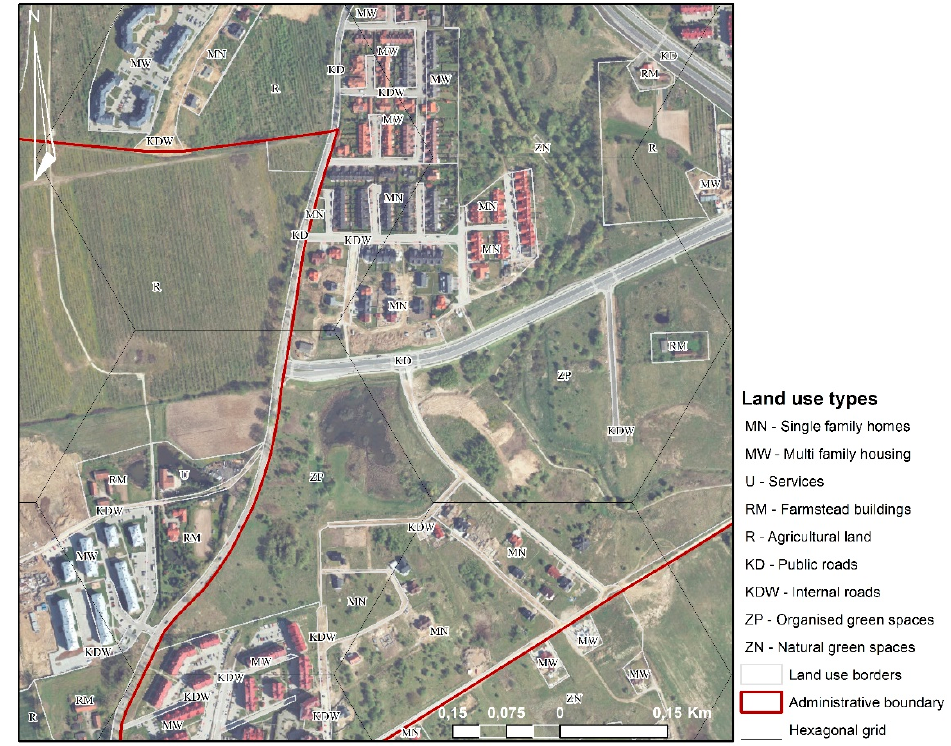
Figure 4. Inventory of the existing land-use types based on 2017 data.